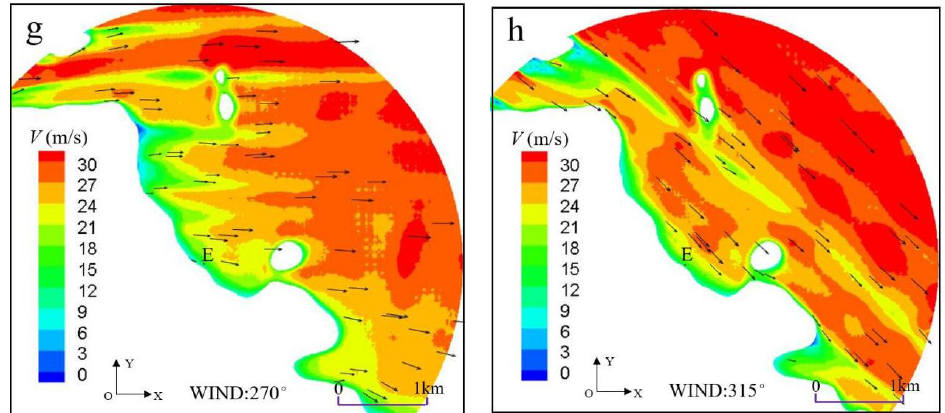
Figure 16. Wind speed cloud map of the ski resort area. ( a ) Incoming wind direction is 0° ( b ) Incoming wind direction is 45° ( c ) Incoming wind direction is 90° ( d ) Incoming wind direction is 135° ( e ) Incoming wind direction is 180° ( f ) Incoming wind direction is 225° ( g ) Incoming wind direction is 270° ( h ) Incoming wind direction is 315°.